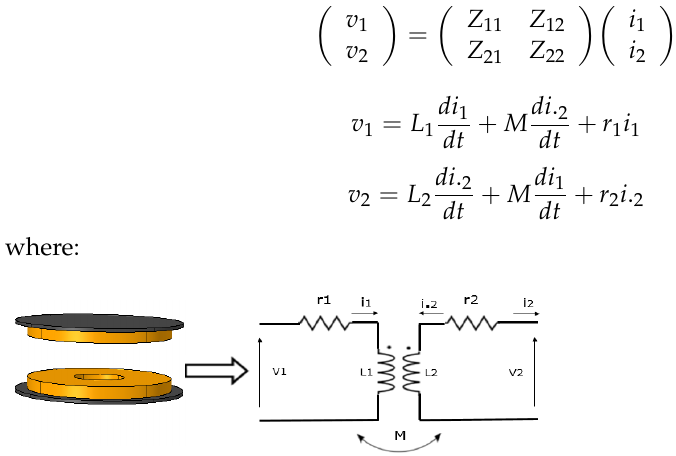
Figure 5. Magnetic circular coupler and its equivalent circuit [38].